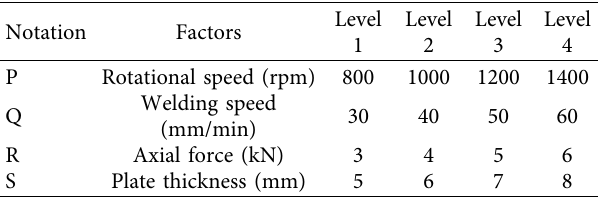
Table 2: Friction stir welding process and its